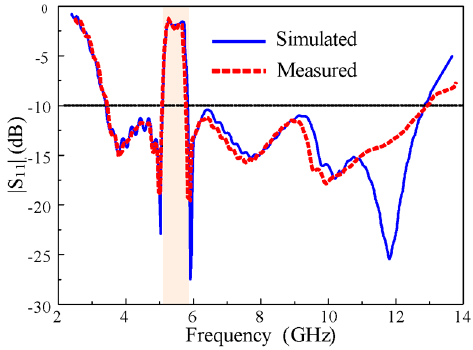
| S | characteristics of the proposed antenna. Figure 14. |S 11 | characteristics of the proposed antenna. Figure 14. 11 Figure 14. |S 11 | characteristics of the proposed antenna.